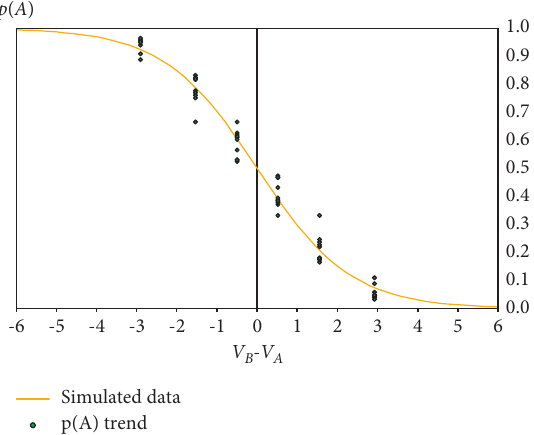
Figure 14: Trend of choice probability p ( A ) as a function of ( V